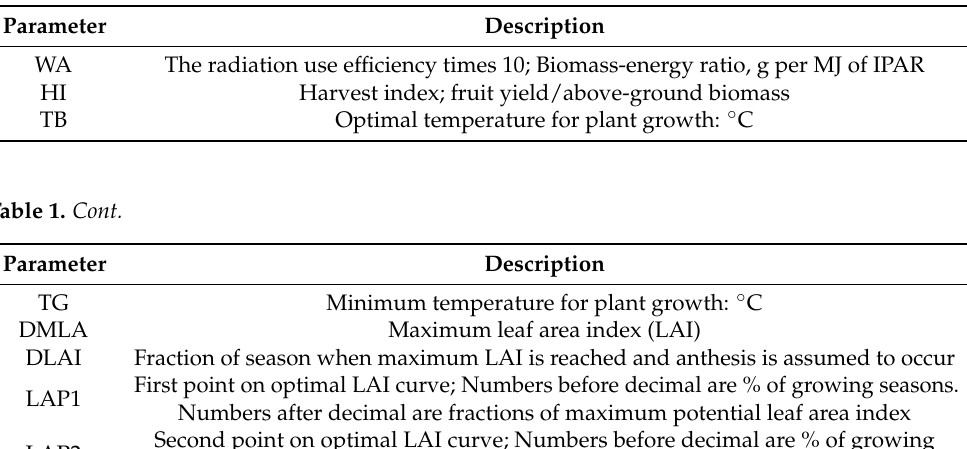
Table 1. Relevant Plant Parameter Descriptions. These parameters were altered to simulate these three tree species. Values for others were the default values for trees previously derived [4,5].